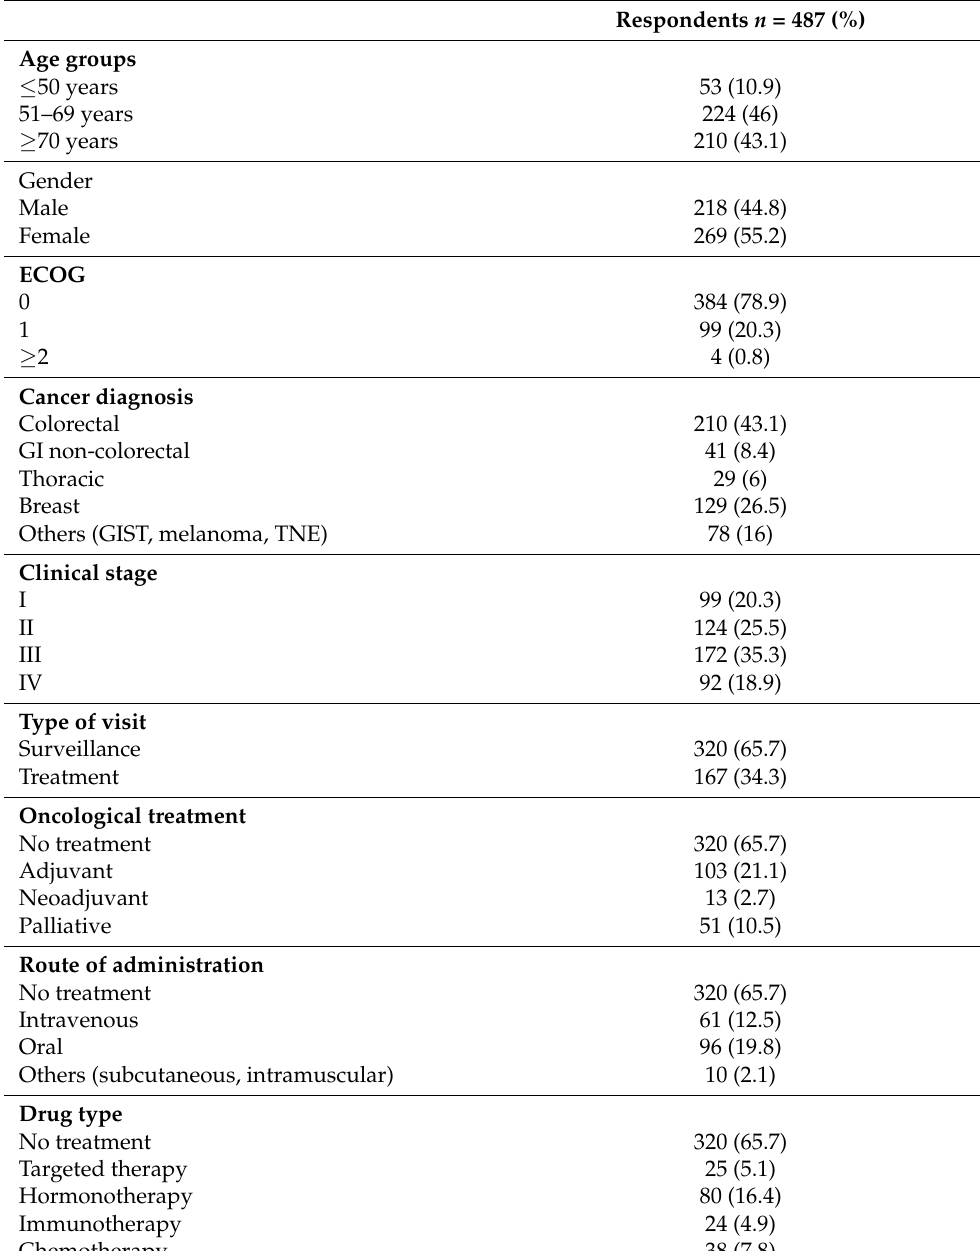
Table 1. Participant demographics, cancer diagnosis, treatment characteristics, and type of